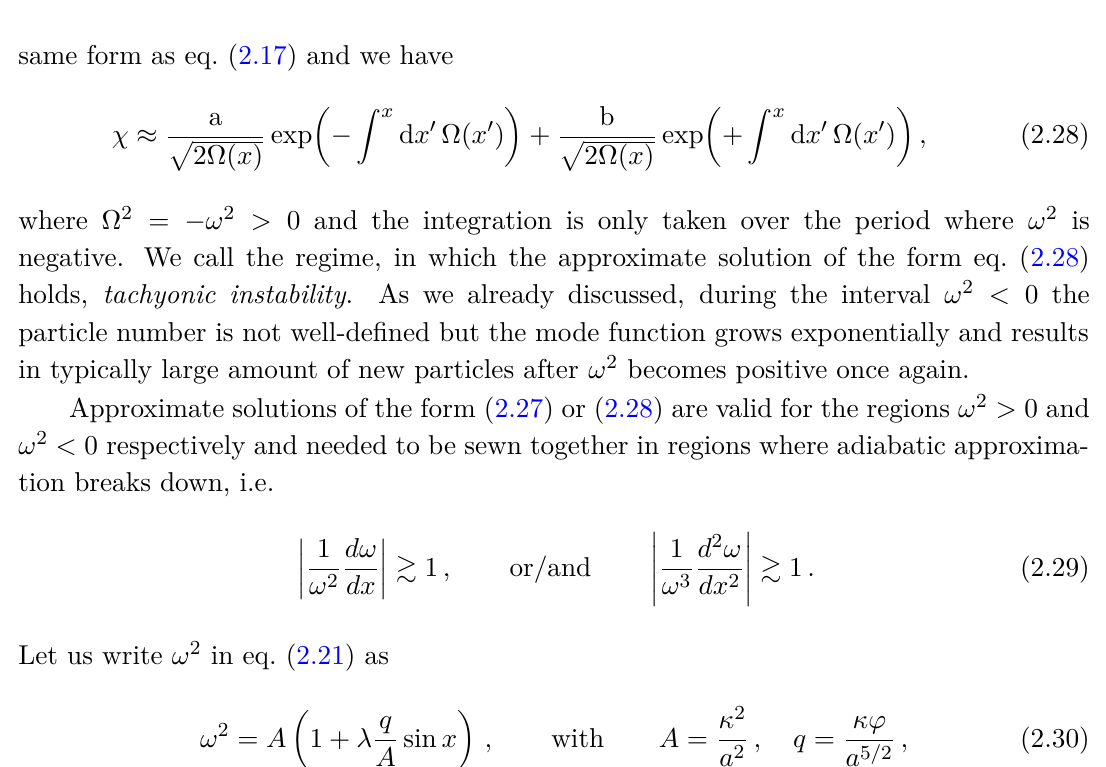
Figure 3 . The effective frequency of the dark photon is of the form ω 2 = A variation of the oscillating term λ q sin x is shown above for λ = − 1 . Below the horizontal dashed A line, the effective frequency of photon ω 2 becomes negative and is shown with the shaded areas. Regions where adiabatic approximation breaks down are marked with red circles. The end of tachyonic regime is specified by x et (see eq. (2.42) and the discussion below it) and after x p (see eq. (2.24)) the effective frequency ω 2 will be always